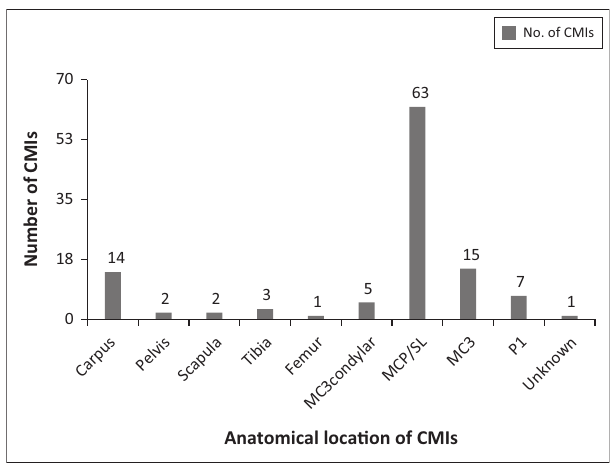
FIGURE 1: Bar chart depicting the anatomical location of the catastrophic musculoskeletal injuries incurred by 114 horses during the racing year period